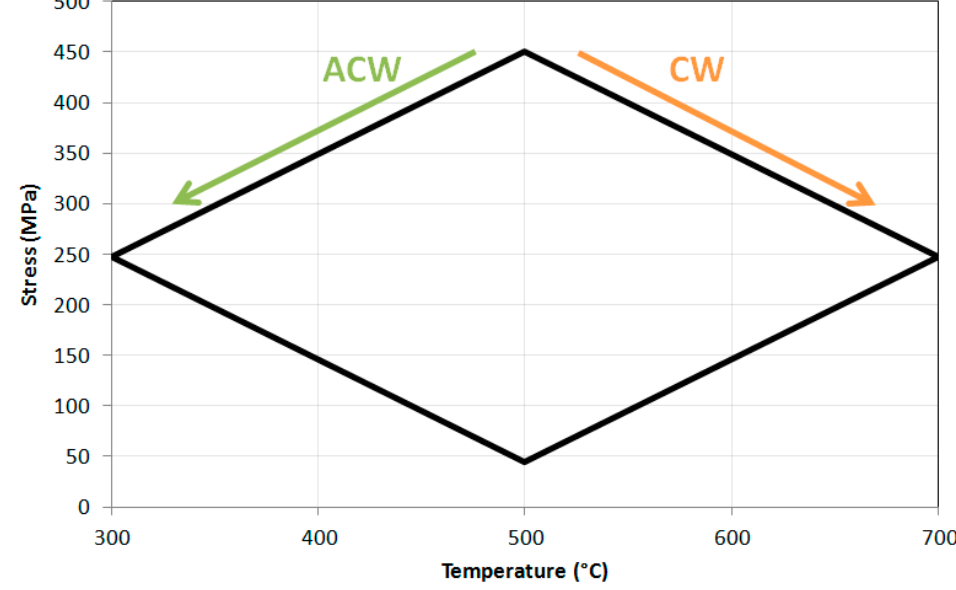
Figure 15. Fracture surfaces of 90° OOP at ∆ K = 20 MPa √ m test in ( a ) ACW and ( b ) CW loading directions.